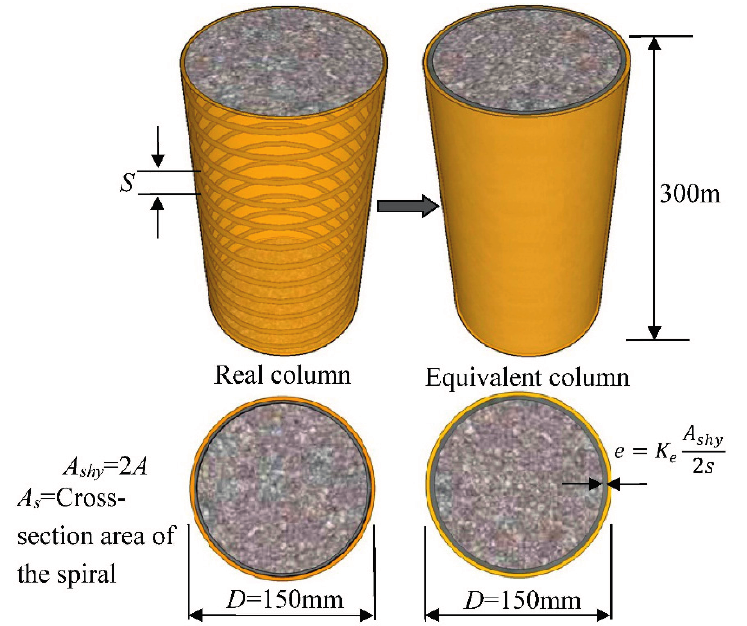
Figure 1. Equivalent steel-confined concrete concept.